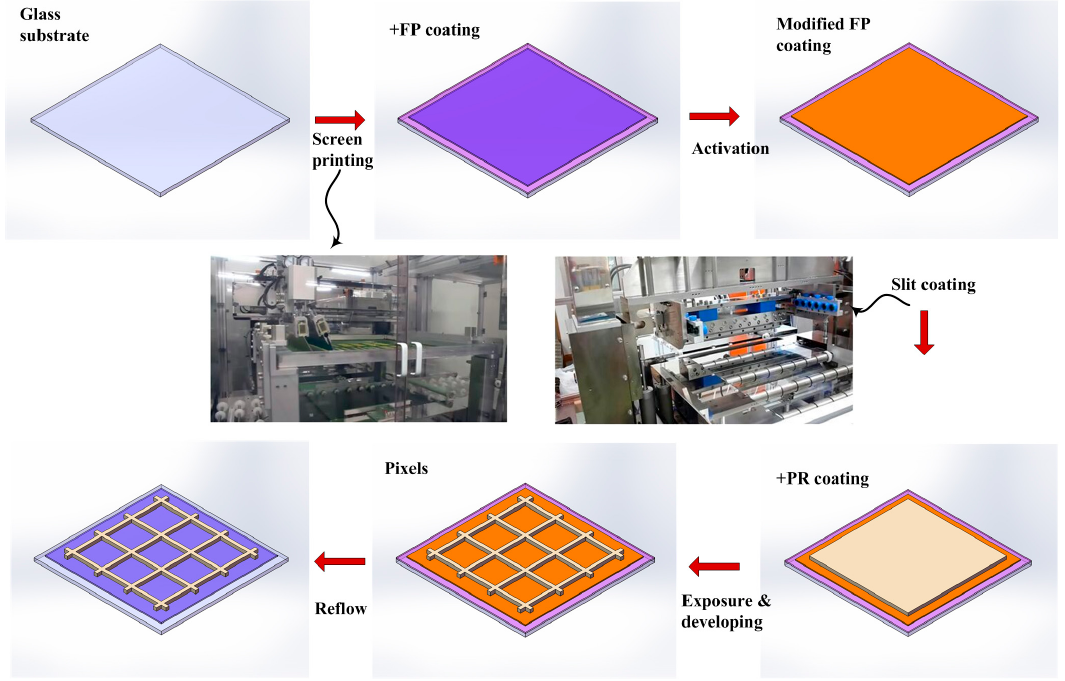
Figure 9. Schematic process flow of fabrication of the large area electrofluidic arrays.